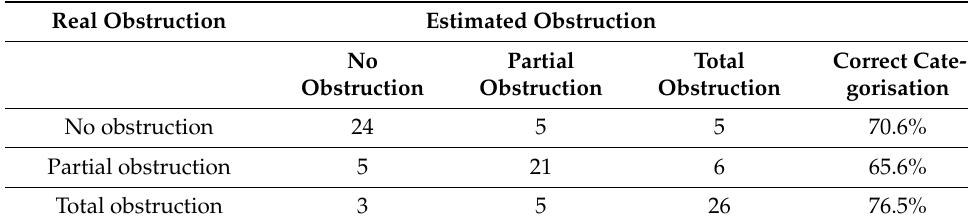
Table 7. Prognosis of tongue-based obstruction and OSA, according to US and MRI measurements (quadratic discriminant analysis).